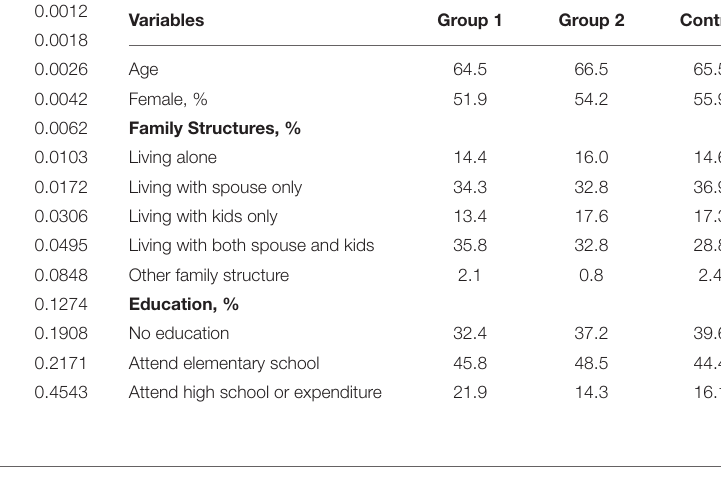
TABLE 7 | Basic characteristics of patients with hypertension in different groups.